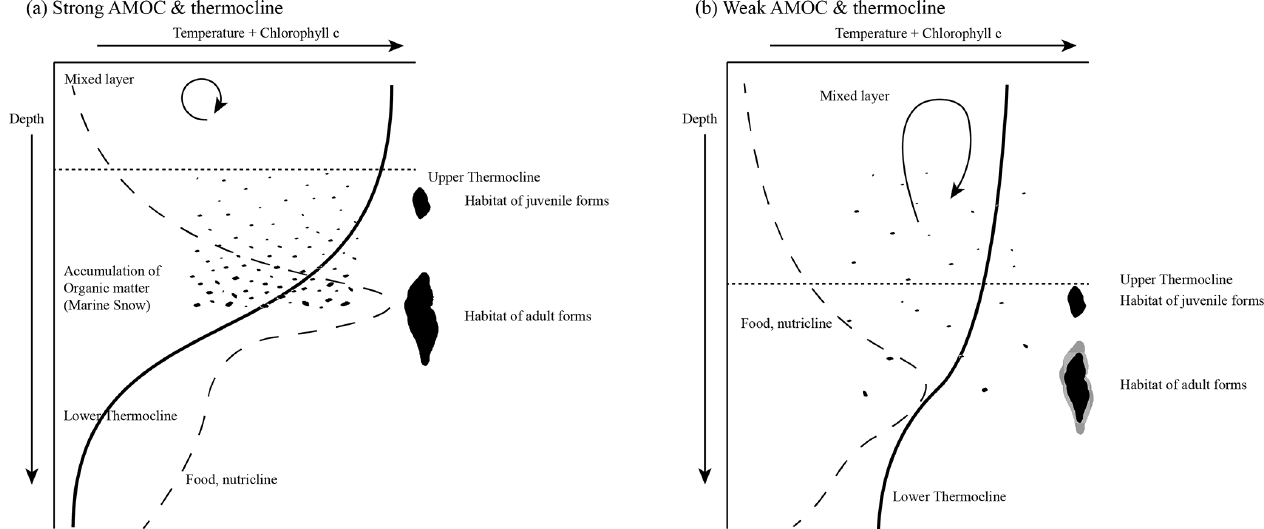
Figure 13. Schematic illustration of the AMOC and thermocline hypothesis. Environmental conditions are expressed as changes in the relative temperature (solid line) and the chlorophyll concentration (dashed line) with increasing depth. (a) Relatively strong AMOC and thermocline. A thin mixed layer consists of relatively warm water, while the subsurface layer is cooler. It causes a strong temperature gradient and thus a strong thermocline. This results in an increased accumulation of organic matter (marine snow) and a high concentration of chlorophyll within the thermocline. The concentration of food and the physical conditions may favour the test growth of G. menardii . (b) A relatively cool and deep mixed layer and a warm subsurface layer develop a weak thermocline. In comparison to strong thermocline conditions, the accumulation of chlorophyll and organic matter is low. The physical conditions may also contribute to a reduction in the test growth of G. menardii . Illustration modified by Brown